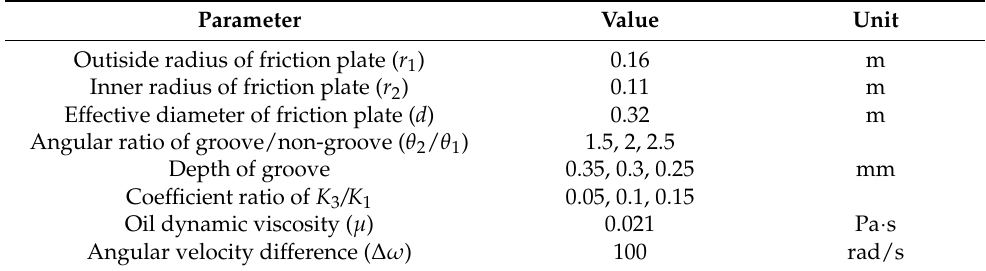
Table 1. Parameters of HVC.